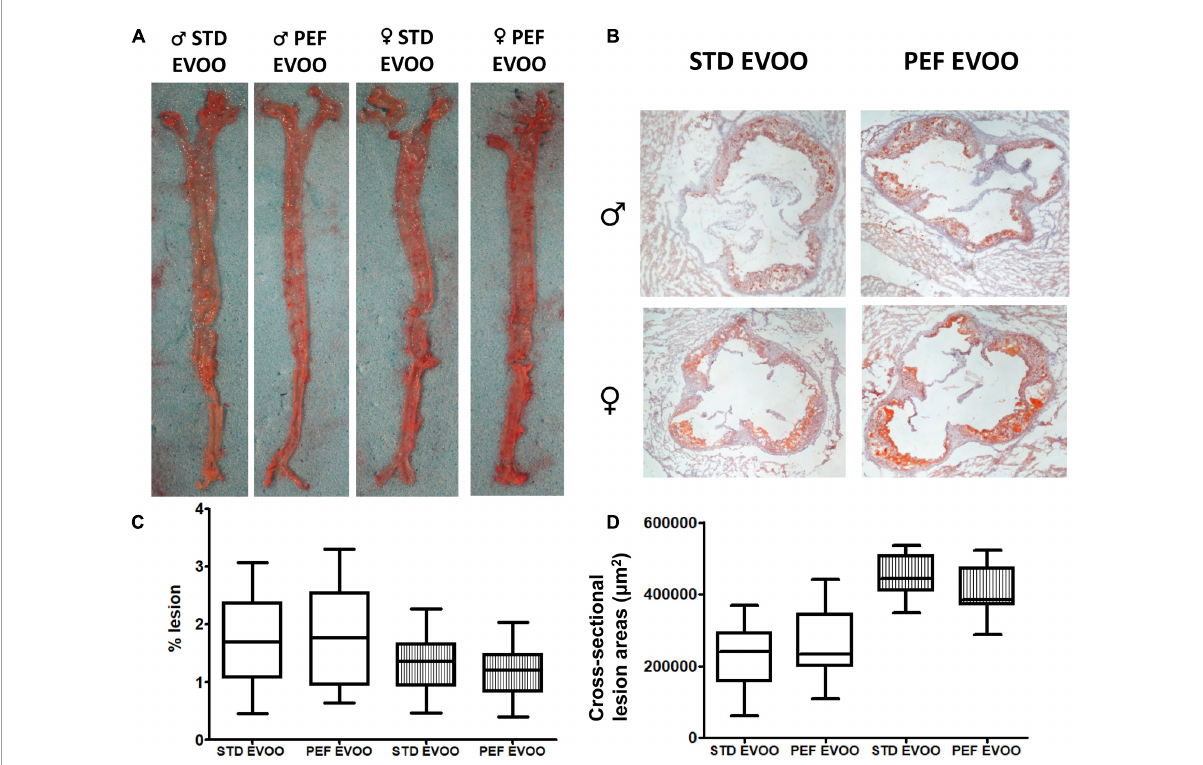
FIGURE2 Effect of EVOO extraction procedure on atherosclerotic lesions in Apoe -KO mice after the dietary intervention. Panel (A) depicts representative en face aorta images and panel (B) , cross-sectional aortic sections. Panel (C) represents results from en face analyses expressed as % of lesion, and panel (D) the cross-sectional lesion areas in µ m 2 . Results are shown as 5–95 percentiles for each group using white boxes for males and striped boxes for females. Statistical analysis was carried out by Mann–Whitney’s- U